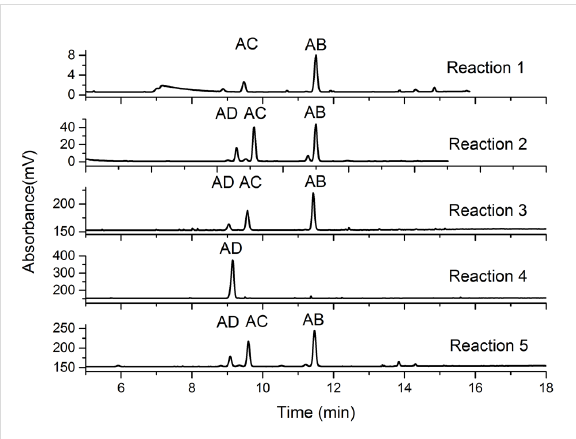
Figure 2: HPLC chromatograms of 6 A ,6 X -diazido- α -CDs 4 of the reac- tions 1–5, with ACN/water gradient elution and ELS detection.